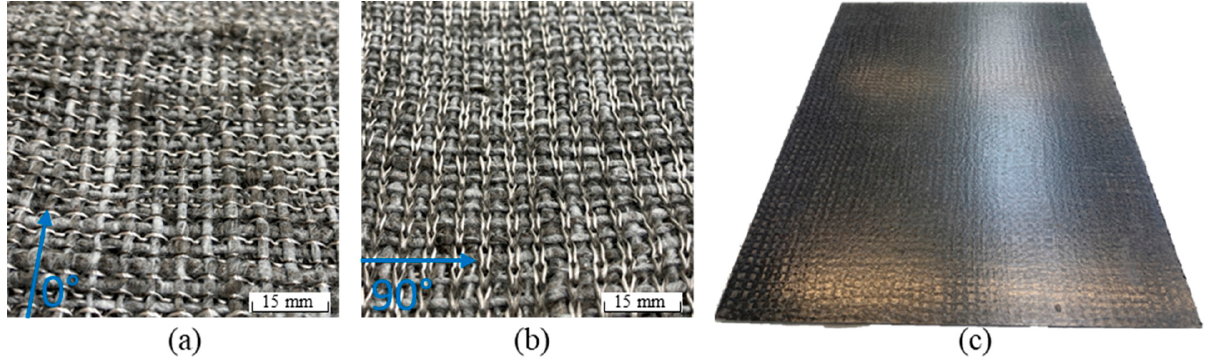
Figure 3. Weft knitted structure from the front ( a ) and the back ( b ) containing the rCF-hybrid yarn in weft (90°) and in warp (0°) directions, and hot-pressed into a ( c ) MLG-composite plates for mechanical characterisation.